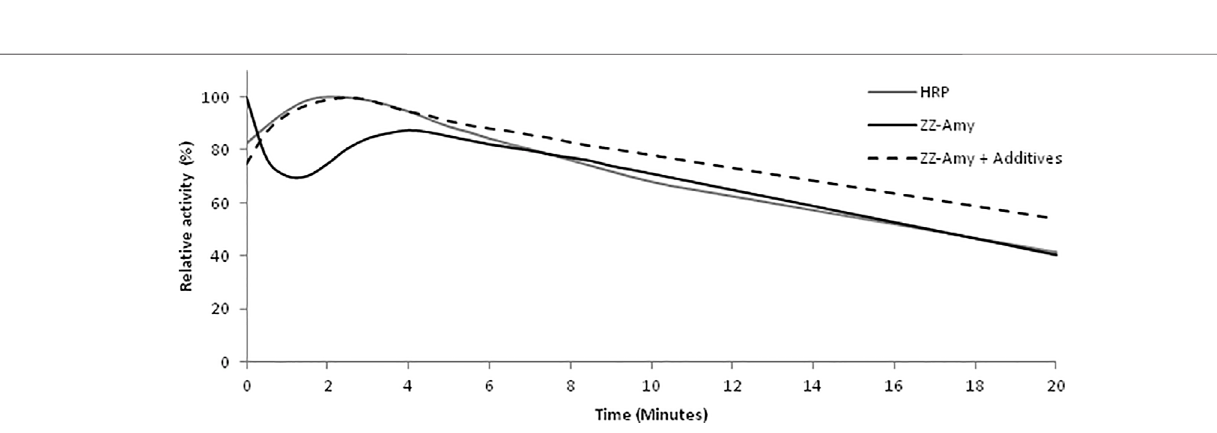
Frontiers in Bioengineering and Biotechnology |